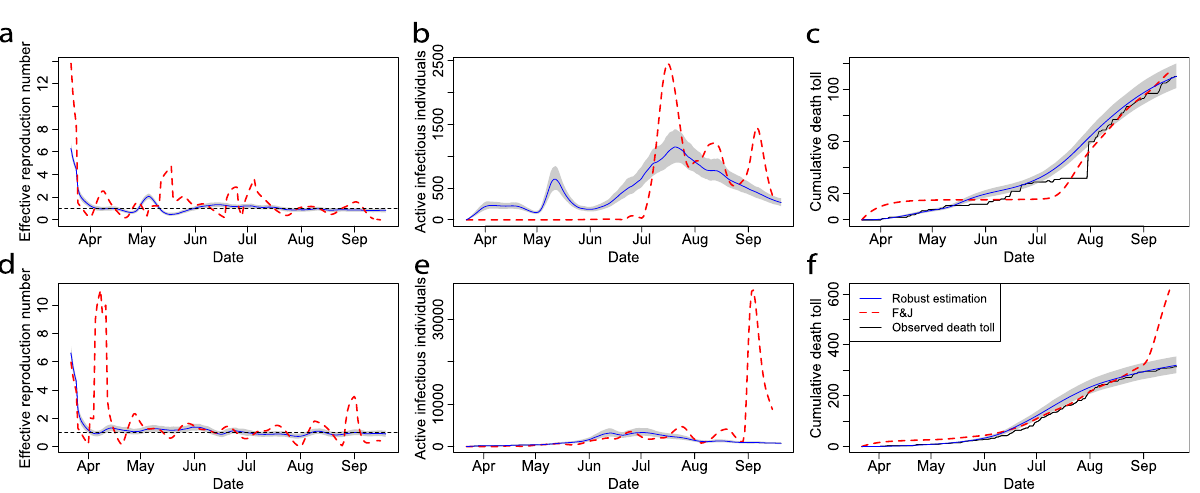
Figure 5. ( a – c ) Comparisons between the estimation COVID-19 progression characteristics for Santa Barbara, CA as of 20 September 2020 by our algorithm 1 (blue solid curves) and the method F & J 9 (red dash curves). The shaded area represents 95% confidence intervals. The black solid curve in part c is the observed cumulative death toll in Santa Barbara. ( d – f ) Results for Imperial, CA as of 20 September 2020, which have the same interpretation as ( a – c ). The transmission rate estimated from the method F & J is truncated to be within